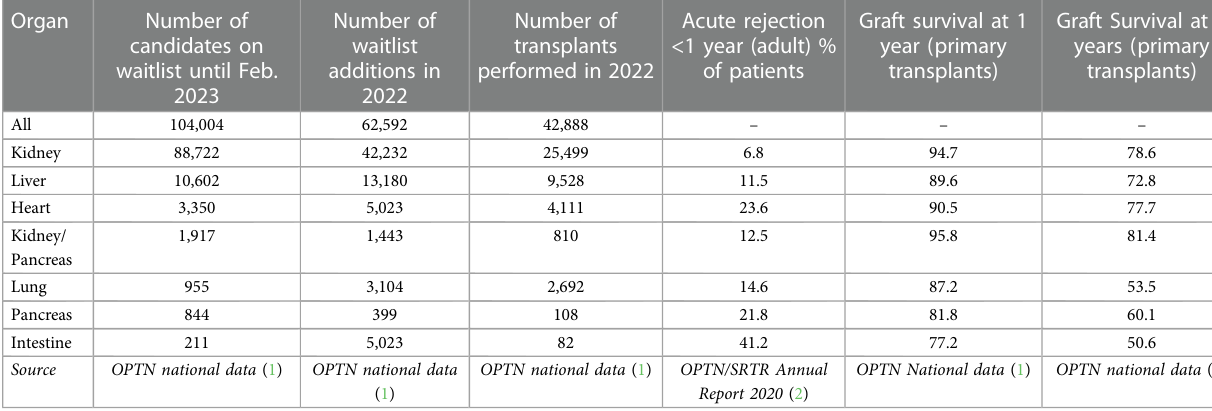
TABLE 1 Transplant waitlist and rejection rates across organs in the